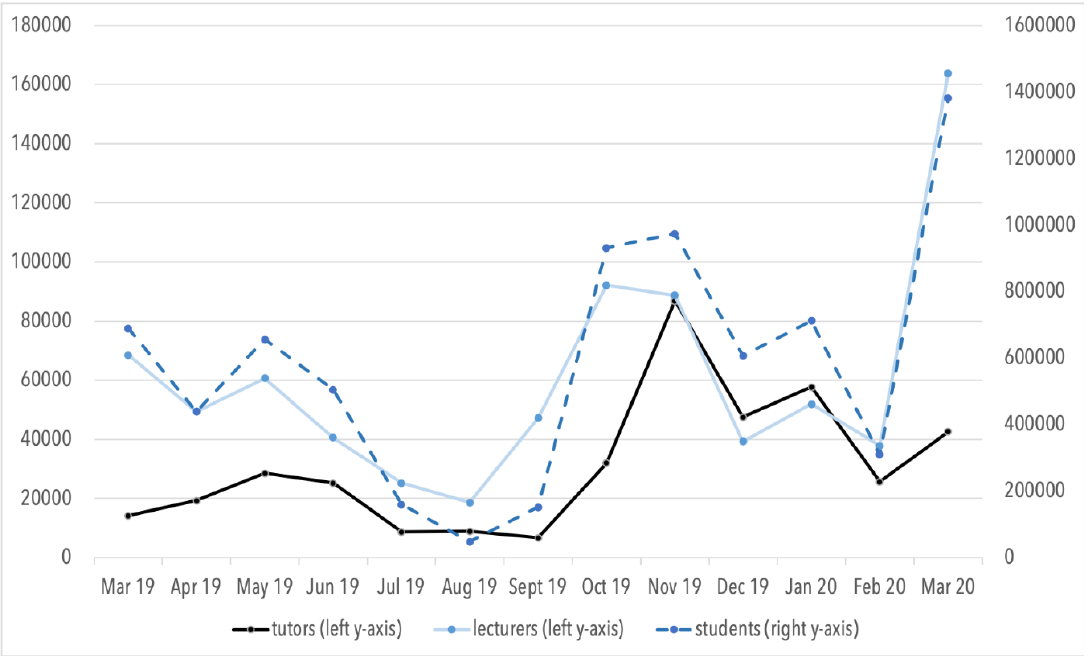
Figure 4. Sum of activities in TeachCenter for different user groups per month from March 2019 to